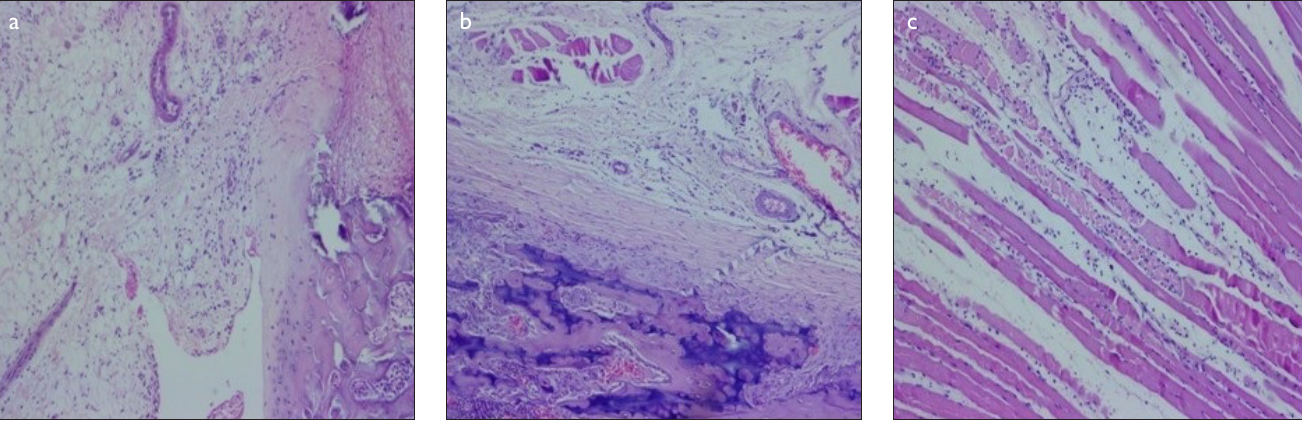
Figure 3. a-c. Hematoxylin-eosin staining of soft tissue necrosis (10x magnification). (a) Saline, (b) 0.5% NaOCl, and (c) 5% NaOCl